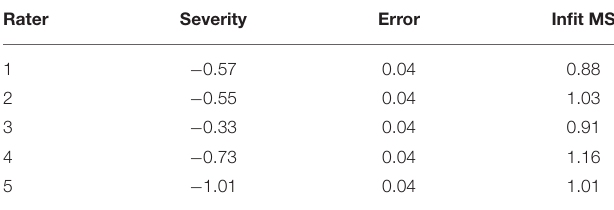
TABLE 6 | FACETS analysis of the severity of raters.